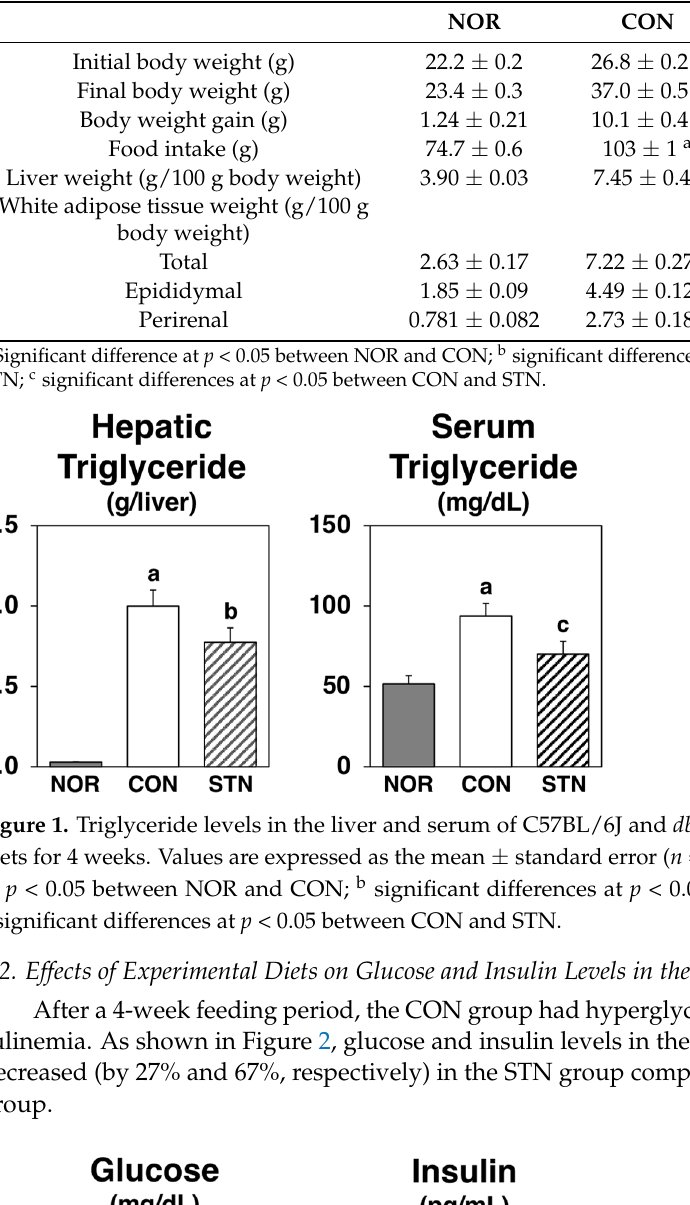
Table 2. Effect of experimental diet on growth parameters in C57BL/6J and db / db mice.